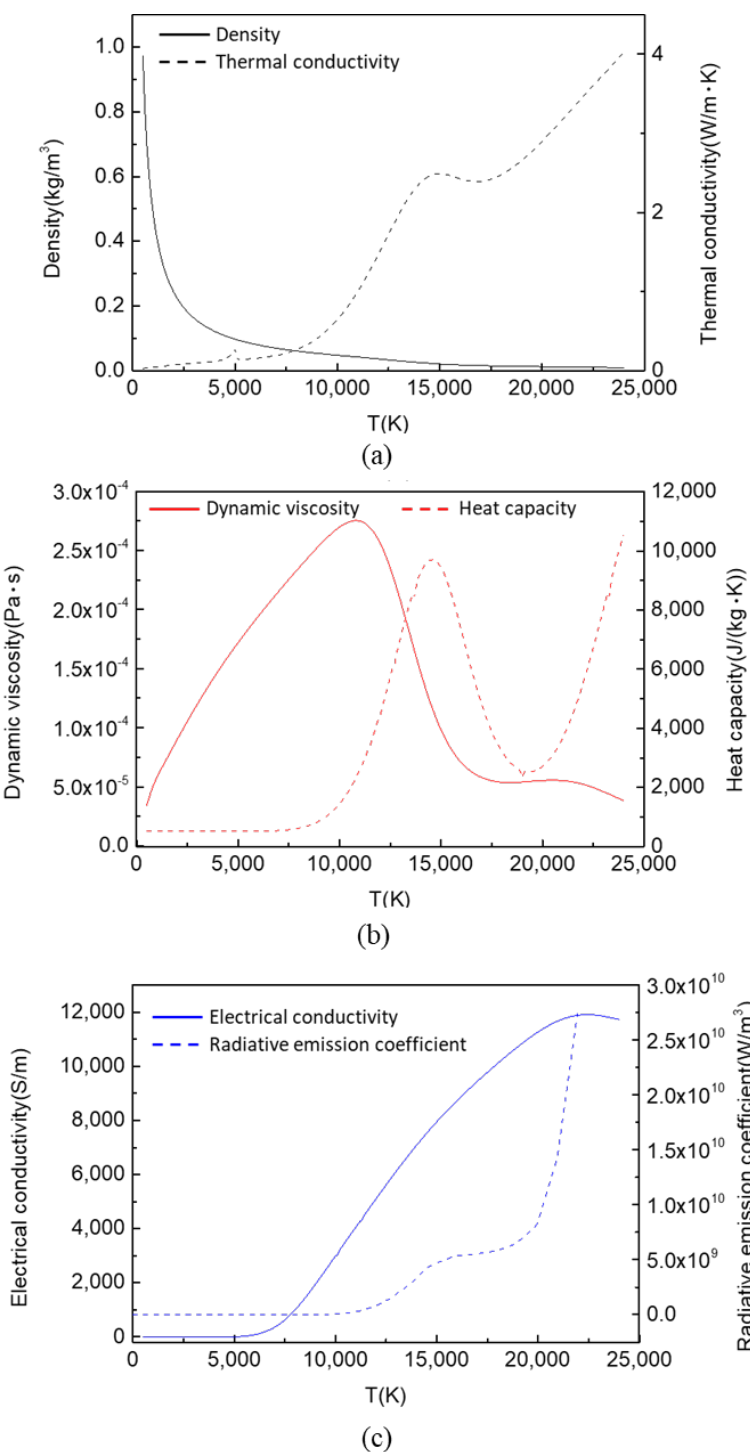
Figure 3. ( a ) Density and thermal conductivity of argon gas; ( b ) Dynamic viscosity and Heat capacity at constant pressure of argon gas; ( c ) Electrical conductivity and Radiative emission coefficient of argon gas.